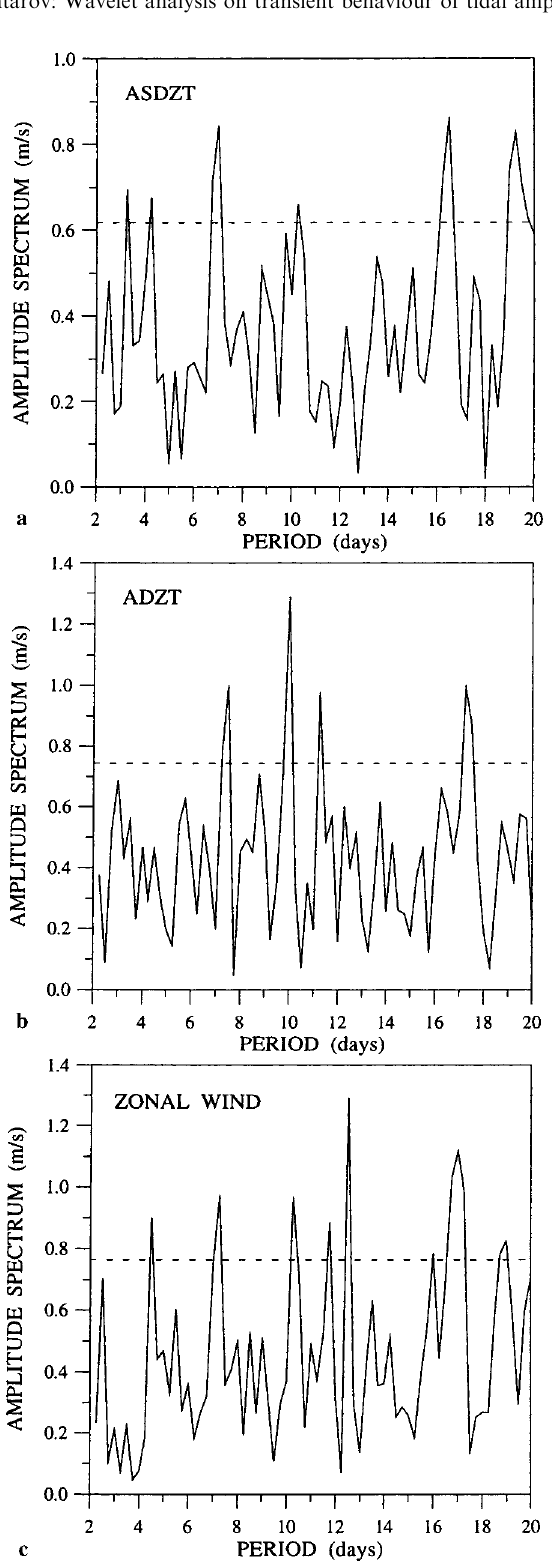
Fig. 1a–c. The amplitude spectra for: a the amplitudes of semidiurnal tide in the zonal wind ( ASDZT ); b the amplitudes of diurnal tide in the zonal wind ( ADZT ); c the prevailing zonal wind, obtained by the method of correloperiodogram analysis, applied to the daily values of tidal wind. The horizontal dashed lines in all spectra represent the 95%